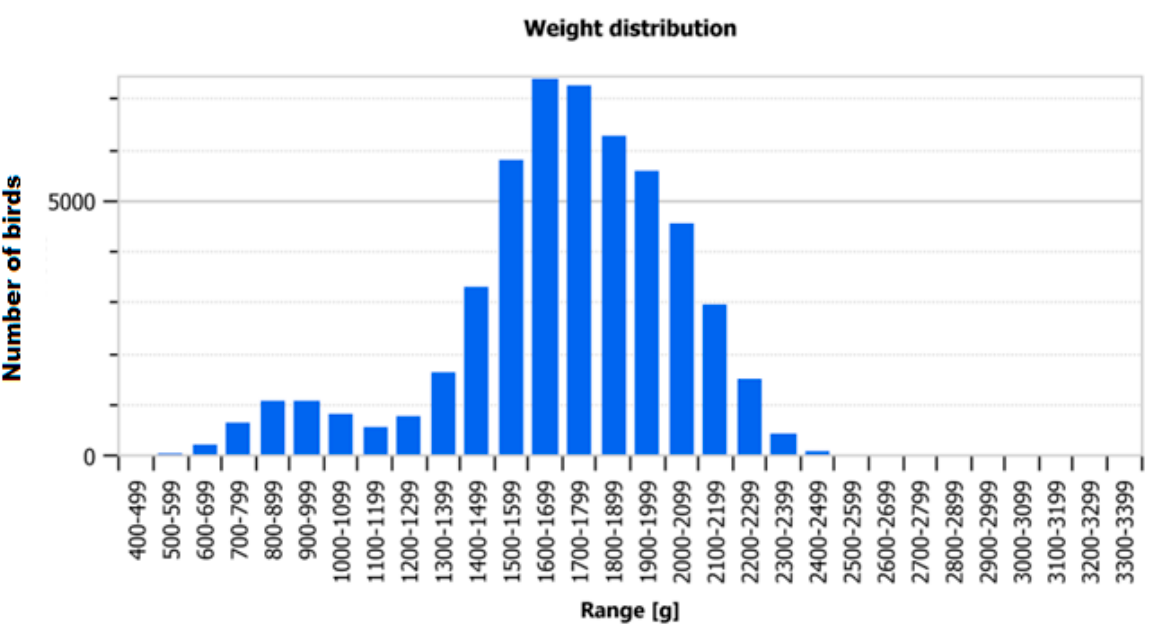
Figure 4. Several flocks where E. coli infection was diagnosed presented a large variation in carcass size and weight.